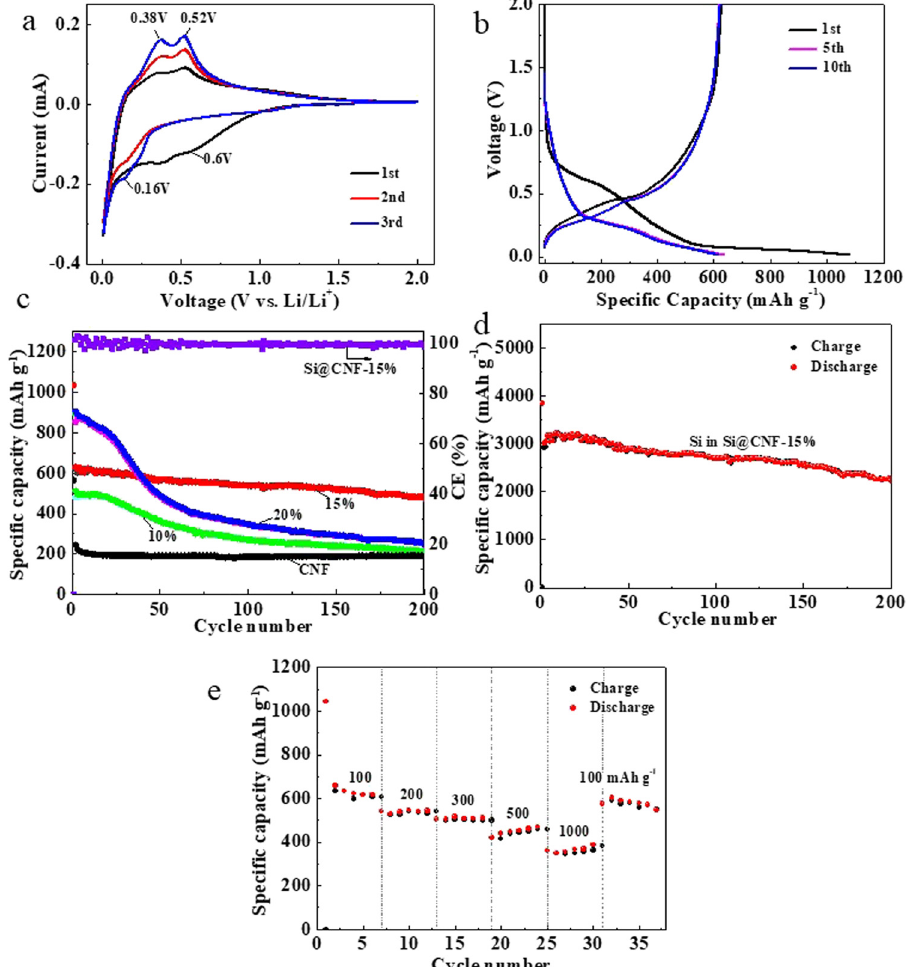
Figure 5: Electrochemical performance of Si@CNF and CNF electrodes: ( a ) CV curves at a scan rate of 0.1 mV s − 1 , ( b ) discharge/charge curves at di ff erent cycles, ( c ) cycling performance at 100 mA g − 1 , ( d ) speci fi c capacity of Si@CNF - 15 wt% is calculated based on the silicon content only and ( e ) rate capabilities at various current densities from 100 to 1,000 mA g − 1